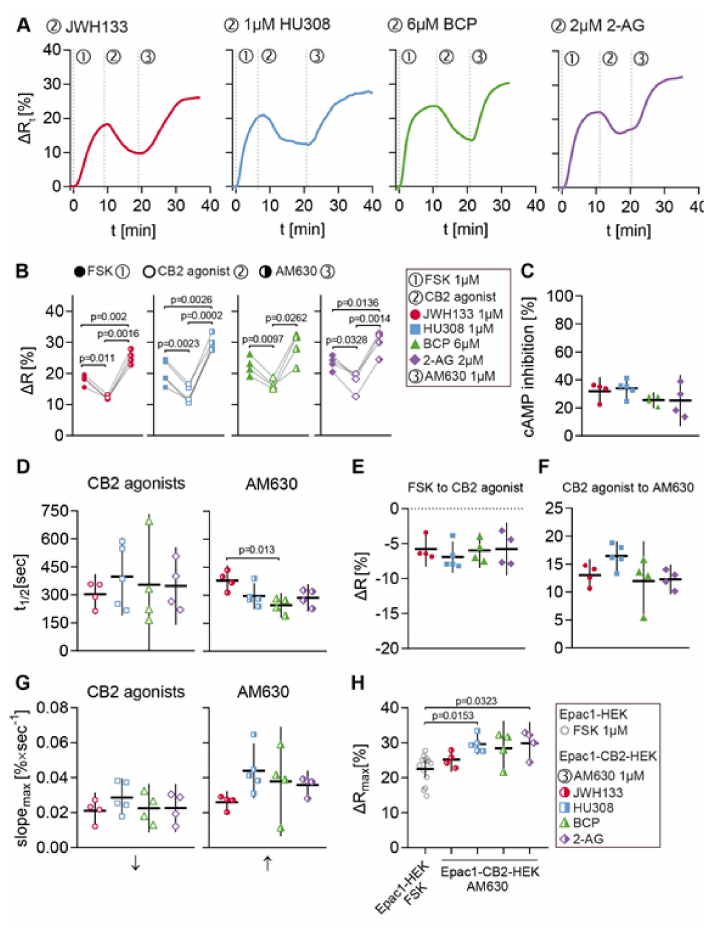
Figure6. FRETresponsestoCB2agonistsandAM630inEpac1-CB2-HEKtypeRcells. ( A